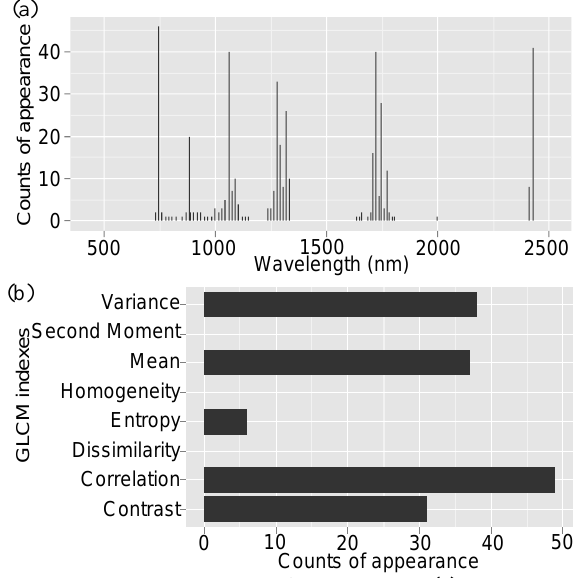
Figure 11. Selected number of spectral bands (a) and texture index (b) in 50 times cross-validation by LASSO regression Table 2 Comparison of prediction accuracy in 50 times cross- validation with spectral and texture data Data